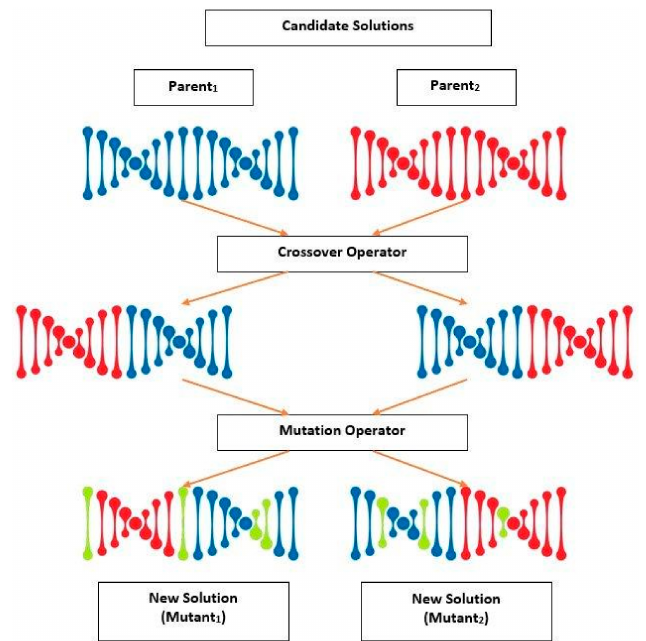
Figure 3. Multi-point crossover